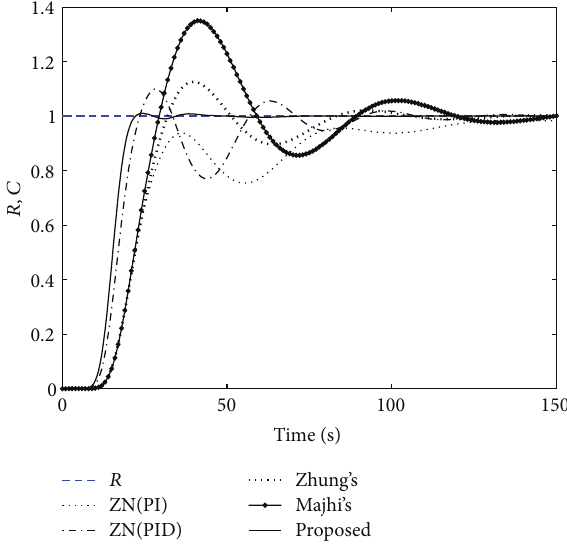
Figure 15: Comparisons with other methods for Example 3.